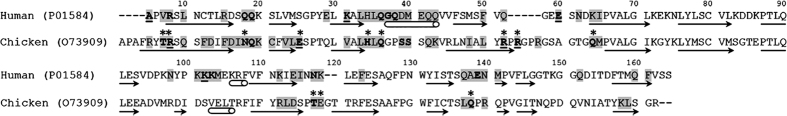
Multiple sequence alignment of human and avian IL-1βs.Sequences used in the alignment are those of human IL-1β (UniProtKB:P01584) and chicken IL-1β (UniProtKB:O73909). Accession numbers are given in the parentheses. Residues directly involved in receptor binding are shaded in gray. Residues that form hydrogen bonds or salt bridges with receptor residues are in bold type or underlined, respectively13. The stars indicate the chicken IL-1β residues selected for in this study.